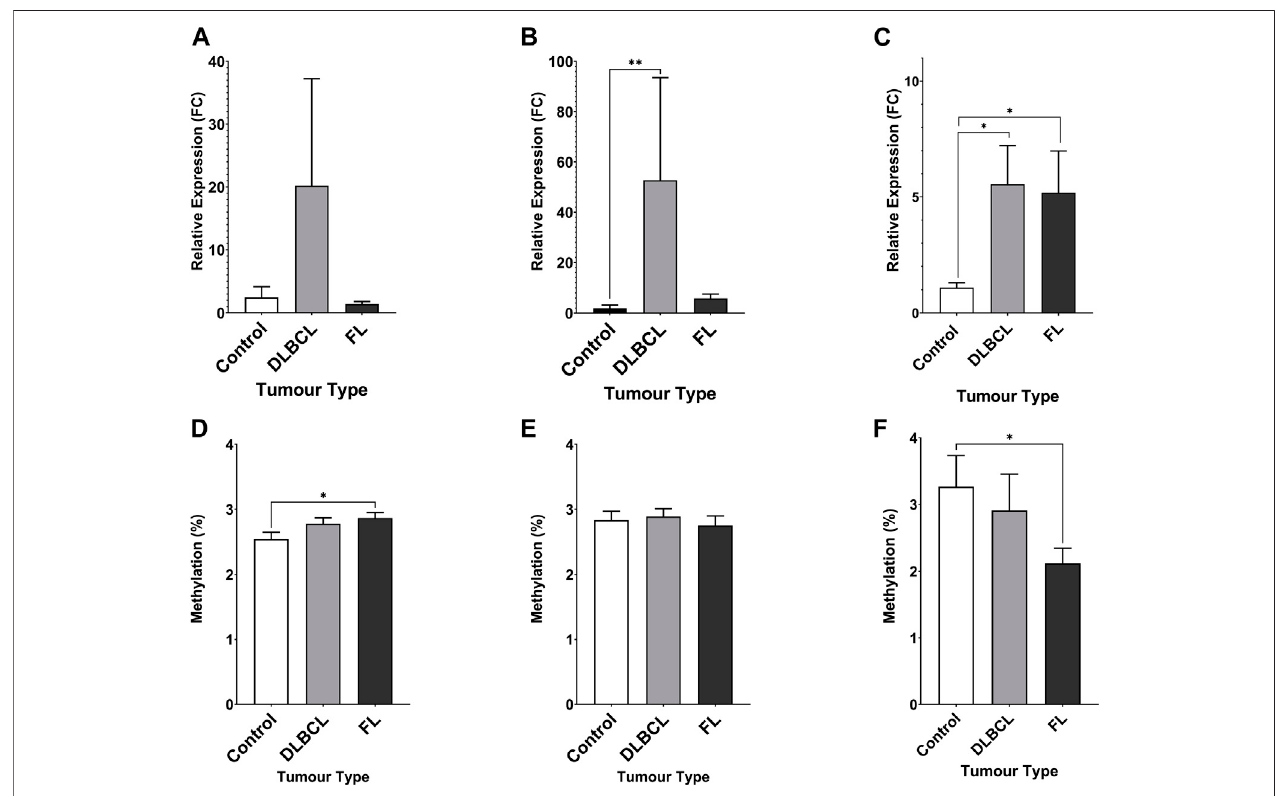
FIGURE3 | Expression miRNA 92a-3p,miRNA92a-3p,and TET2 mRNA, and promoter DNA methylation ofCpGs in tworegionsof thepromoter CGI ofthe miR- 17 ∼ 92 cluster and one region in thepromoter CGI ofthe TET2 genein NHL tumours compared to healthy control PBMCs. The expression ofmiR-92a-3p (A) , miR-92a- 5p (B) and TET2 mRNA (C) was assayed in by RT-qPCR in malignant lymphatic tissue of NHL patients and in healthy control PBMCs. Bisul fi te pyrosequencing was performedontworegionsinthepromoterCGIsofthemiR-17 – 92clusterandinoneregionoftheTET2gene.Meanmethylationlevelsof4CpGsinthetworegions, 532 bp (D) and 774 bp (E) upstream of the MIR17HG TSS were assayed, and mean methylation levels of 6 CpGs in the fi rst exon of TET2 were also assayed (F) . Bars denote mean and error bars denote SEM. Statistical signi fi cance calculated by KW test of signi fi cance and a post-hoc Dunn test for comparison of cell lines to controls, with signi fi cance denoted as: **** p < 0.0001, *** p < 0.001, ** p < 0.01, * p <